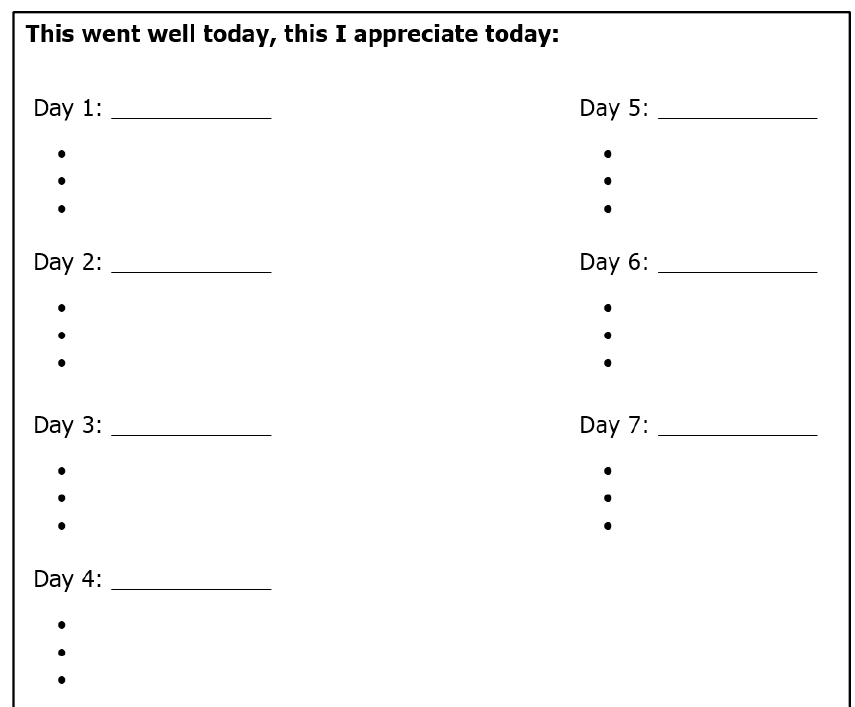
Figure A1. Worksheet for the ‘Pleasure song’.